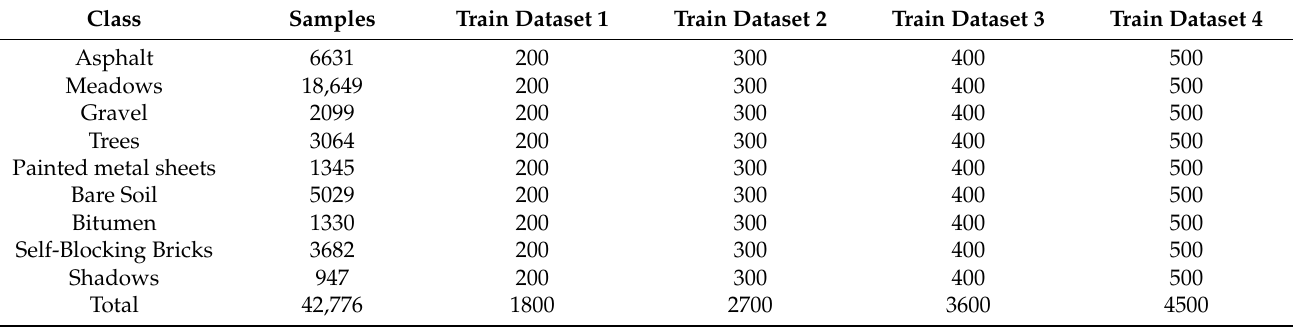
Table 5. Ground truth classes for the Pavia University data and their respective numbers of